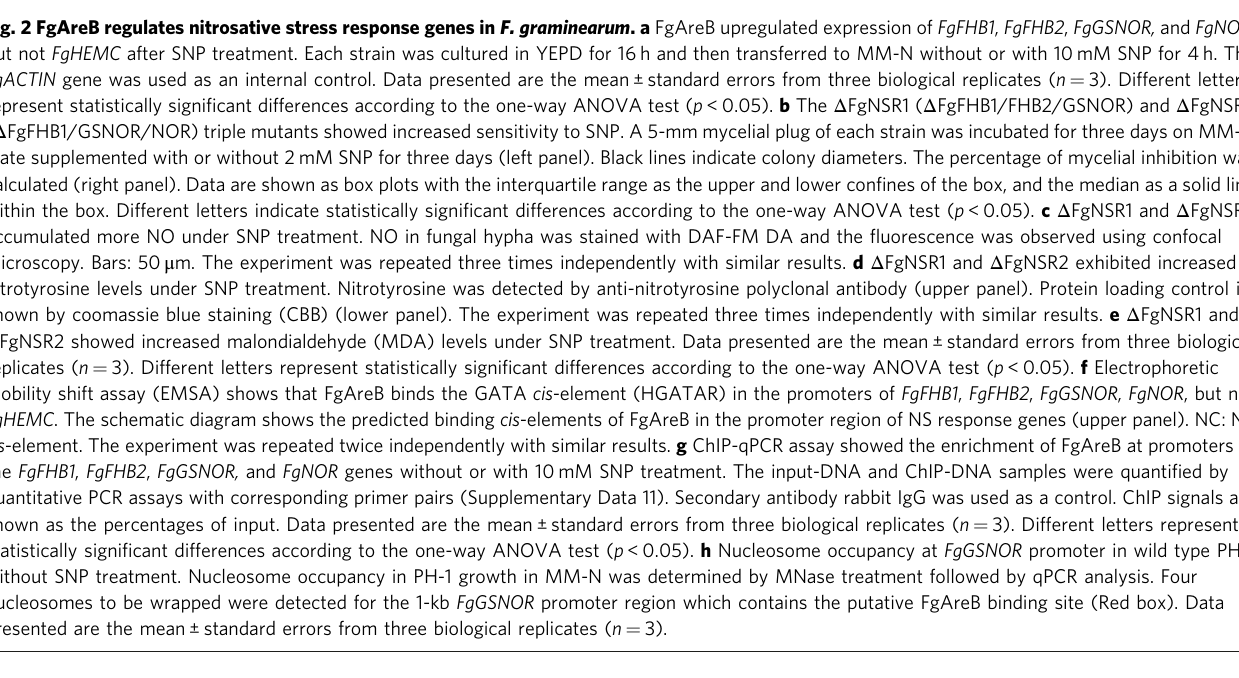
Fig. 2 FgAreB regulates nitrosative stress response genes in F. graminearum . a FgAreB upregulated expression of FgFHB1 , FgFHB2 , FgGSNOR, and FgNOR , but not FgHEMC after SNP treatment. Each strain was cultured in YEPD for 16 h and then transferred to MM-N without or with 10 mM SNP for 4 h. The FgACTIN gene was used as an internal control. Data presented are the mean ± standard errors from three biological replicates ( n = 3). Different letters represent statistically signi fi cant differences according to the one-way ANOVA test ( p < 0.05). b The Δ FgNSR1 ( Δ FgFHB1/FHB2/GSNOR) and Δ FgNSR2 ( Δ FgFHB1/GSNOR/NOR) triple mutants showed increased sensitivity to SNP. A 5-mm mycelial plug of each strain was incubated for three days on MM-N plate supplemented with or without 2 mM SNP for three days (left panel). Black lines indicate colony diameters. The percentage of mycelial inhibition was calculated (right panel). Data are shown as box plots with the interquartile range as the upper and lower con fi nes of the box, and the median as a solid line within the box. Different letters indicate statistically signi fi cant differences according to the one-way ANOVA test ( p < 0.05). c Δ FgNSR1 and Δ FgNSR2 accumulated more NO under SNP treatment. NO in fungal hypha was stained with DAF-FM DA and the fl uorescence was observed using confocal microscopy. Bars: 50 μ m. The experiment was repeated three times independently with similar results. d Δ FgNSR1 and Δ FgNSR2 exhibited increased nitrotyrosine levels under SNP treatment. Nitrotyrosine was detected by anti-nitrotyrosine polyclonal antibody (upper panel). Protein loading control is shown by coomassie blue staining (CBB) (lower panel). The experiment was repeated three times independently with similar results. e Δ FgNSR1 and Δ FgNSR2 showed increased malondialdehyde (MDA) levels under SNP treatment. Data presented are the mean ± standard errors from three biological replicates ( n = 3). Different letters represent statistically signi fi cant differences according to the one-way ANOVA test ( p < 0.05). f Electrophoretic mobility shift assay (EMSA) shows that FgAreB binds the GATA cis -element (HGATAR) in the promoters of FgFHB1 , FgFHB2 , FgGSNOR , FgNOR , but not FgHEMC . The schematic diagram shows the predicted binding cis -elements of FgAreB in the promoter region of NS response genes (upper panel). NC: No cis -element. The experiment was repeated twice independently with similar results. g ChIP-qPCR assay showed the enrichment of FgAreB at promoters of the FgFHB1 , FgFHB2 , FgGSNOR, and FgNOR genes without or with 10 mM SNP treatment. The input-DNA and ChIP-DNA samples were quanti fi ed by quantitative PCR assays with corresponding primer pairs (Supplementary Data 11). Secondary antibody rabbit IgG was used as a control. ChIP signals are shown as the percentages of input. Data presented are the mean ± standard errors from three biological replicates ( n = 3). Different letters represent statistically signi fi cant differences according to the one-way ANOVA test ( p < 0.05). h Nucleosome occupancy at FgGSNOR promoter in wild type PH-1 without SNP treatment. Nucleosome occupancy in PH-1 growth in MM-N was determined by MNase treatment followed by qPCR analysis. Four nucleosomes to be wrapped were detected for the 1-kb FgGSNOR promoter region which contains the putative FgAreB binding site (Red box). Data presented are the mean ± standard errors from three biological replicates ( n =